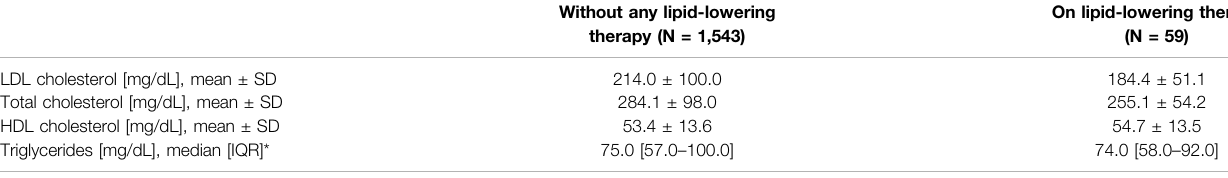
Without any lipid-lowering therapy (N = 1,543)